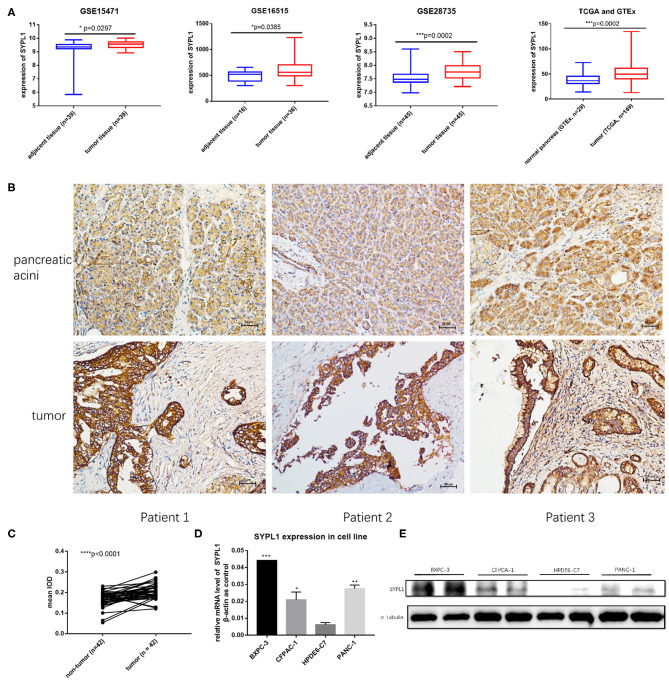
SYPL1 was upregulated in pancreatic ductal adenocarcinoma (PDAC). (A) SYPL1 was upregulated in PDAC at the transcription level (GSE15471, GSE16515, GSE28735, TCGA, and GTEx datasets were used). (B) The expression of SYPL1 in tumor and pancreatic acini at the protein level. Tissue sections from three PDAC patients were used as examples. (C) Quantification of SYPL1 protein levels in 42 paired tumor sections and pancreatic acini sections. (D) Quantification of SYPL1 RNA in PDAC cell lines (BXPC-3, CFPAC-1, and PANC-1) and immortal human pancreatic duct epithelial cell lines HPDE6-C7. (E) SYPL1 protein levels in cell lines. *p < 0.05, ***p < 0.001 and ****p < 0.0001.